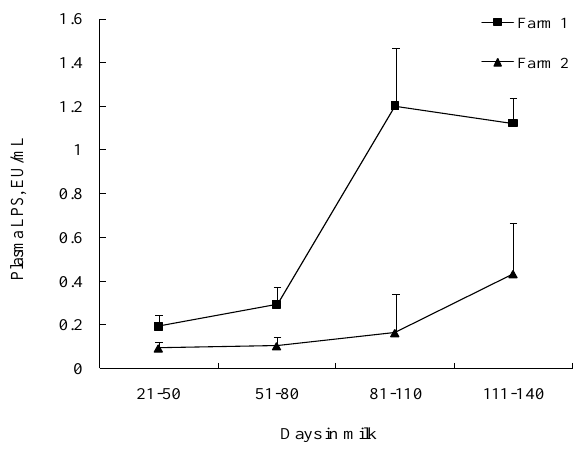
Figure 3. Effect of DIM on plasma lipopolysaccharide (LPS) concentration (Endotoxin Unit